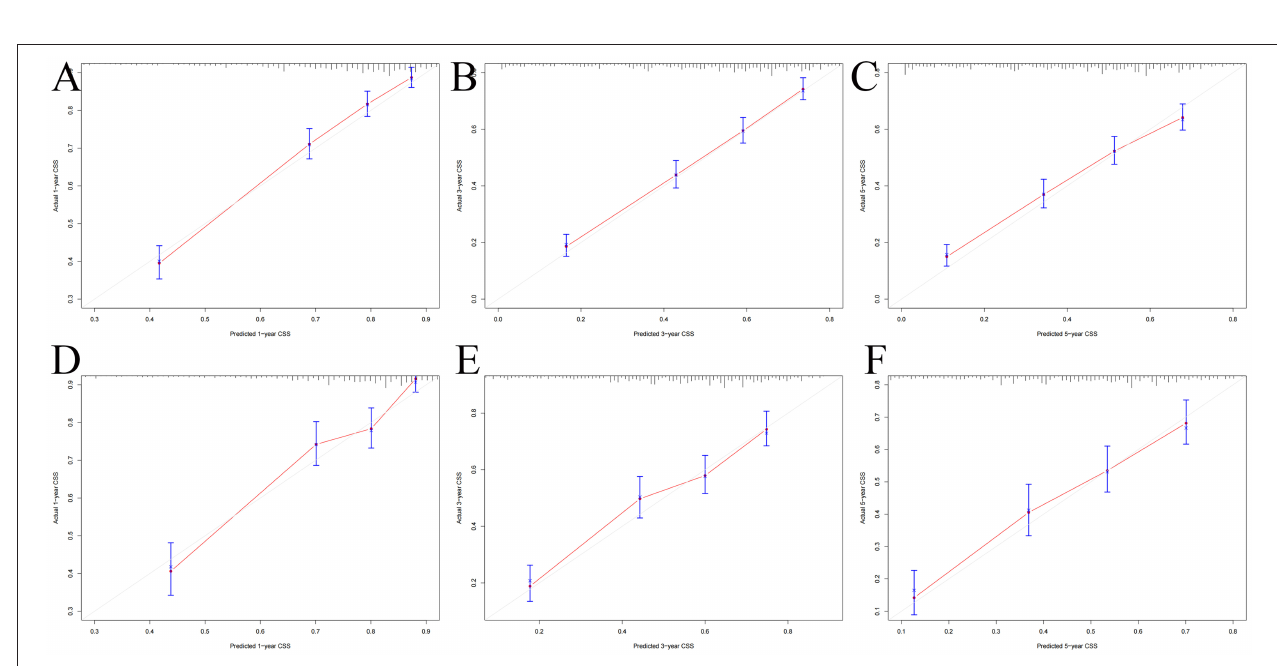
FIGURE 3 | Calibration curves of the nomogram. (A–C) For 1-, 3-, and 5-year CSS in the training set; (D–F) For 1-, 3-, and 5-year CSS in the validation set.